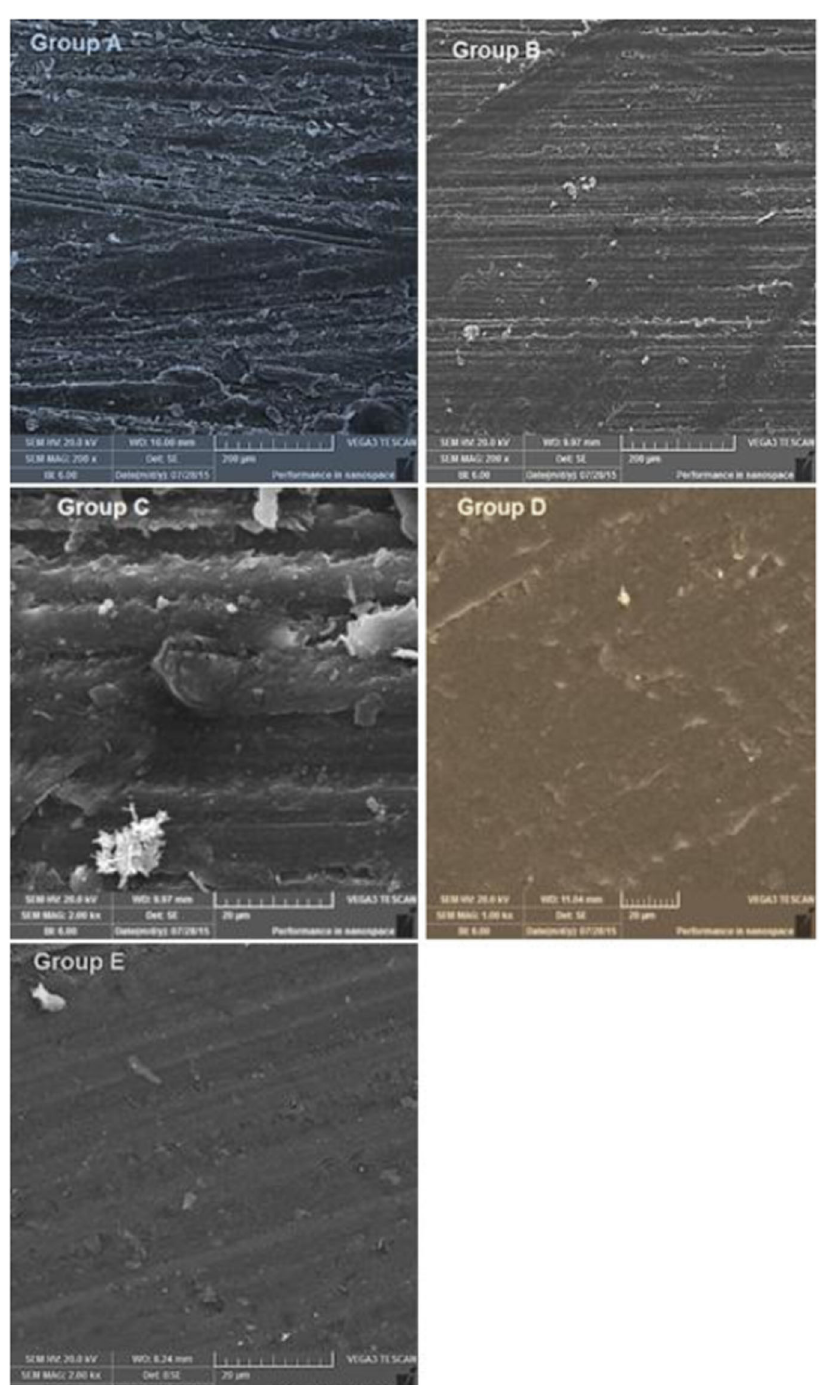
Fig. 7 SEM micrographs of fracture surfaces of arti fi cial teeth after compressions